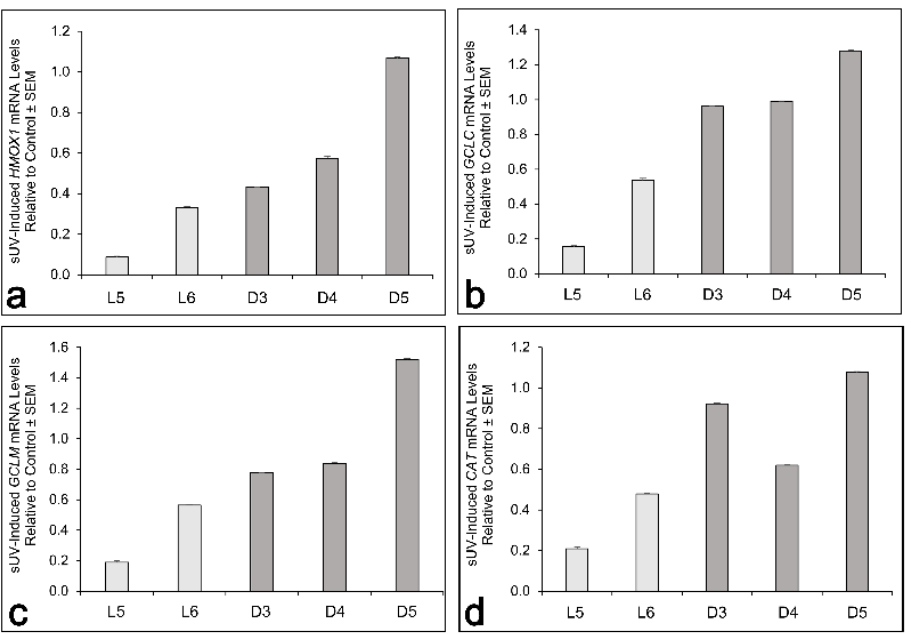
Figure 5. Early effect of solar UV on the mRNA levels of HMOX1 ( a ), GCLC ( b ), GCLM ( c ), and CAT ( d ), as determined by RT PCR 3 h post-irradiation in 2 L and 3 D melanocyte cultures. Each bar represents the mean mRNA value of triplicate samples/group relative to the control ± SEM.